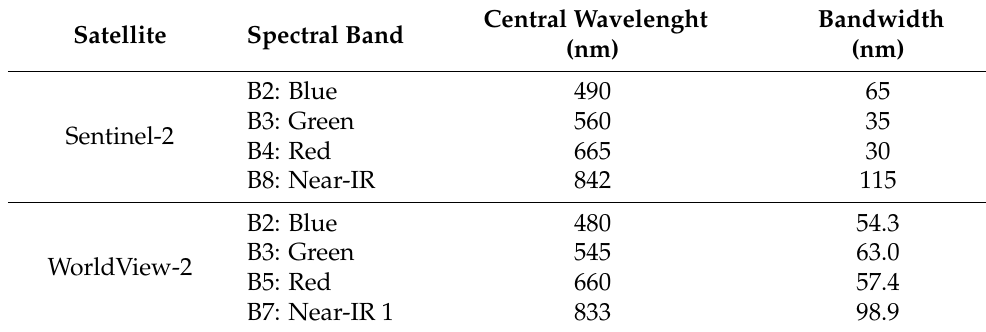
Table 1. Sentinel-2 and WorldView-2 band spectral characteristics.